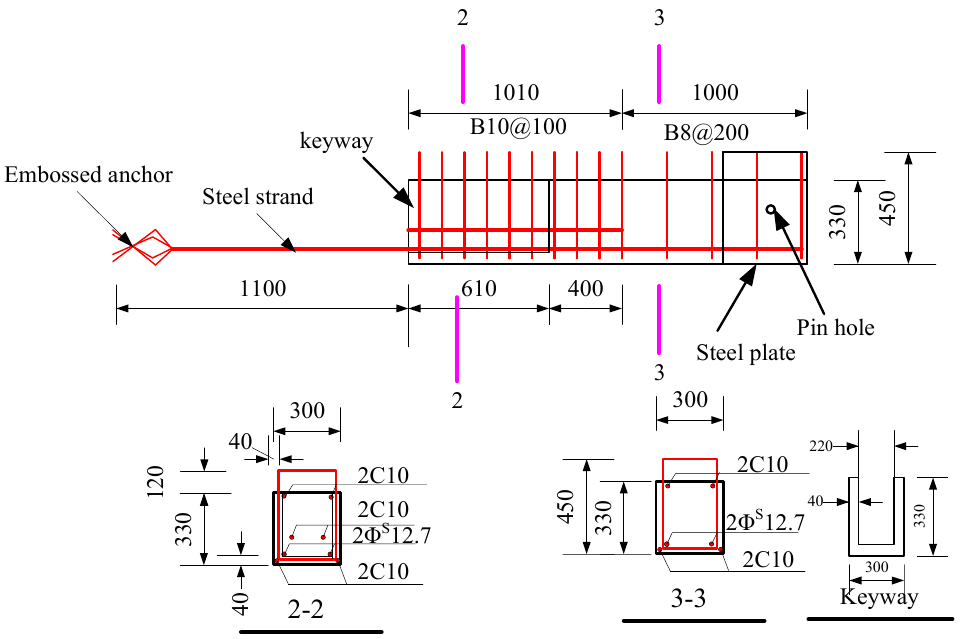
Figure 4. The precast beam details of YZ2 (Unit: mm).